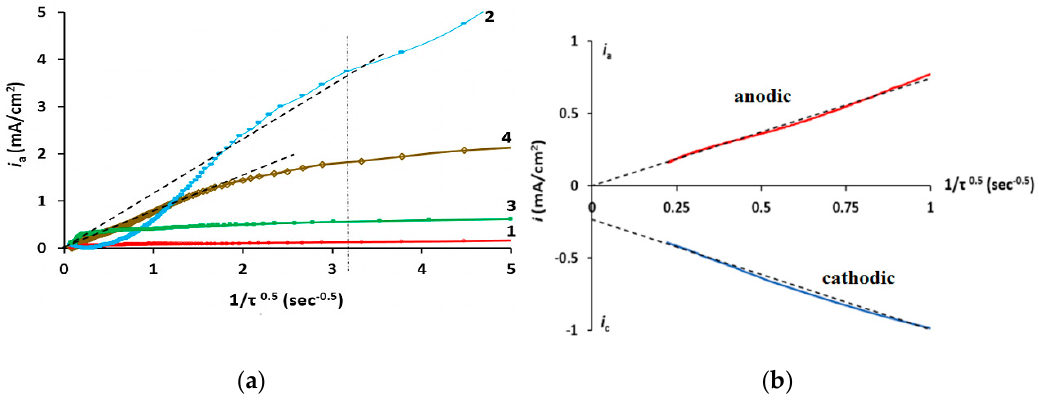
Figure 6. ( a ) Transients of anodic current at − 0.3 V (SHE) in solutions: (1) BB; (2) BB + 0.6 M NaCl; (3) BB + NS4 + TU; (4) 0.1 M NaCl. ( b ) Initial parts of anodic ( − 0.3 V vs. SHE) and cathodic ( − 1 V vs. SHE) current transients in 0.1 M NaCl aqueous electrolyte.